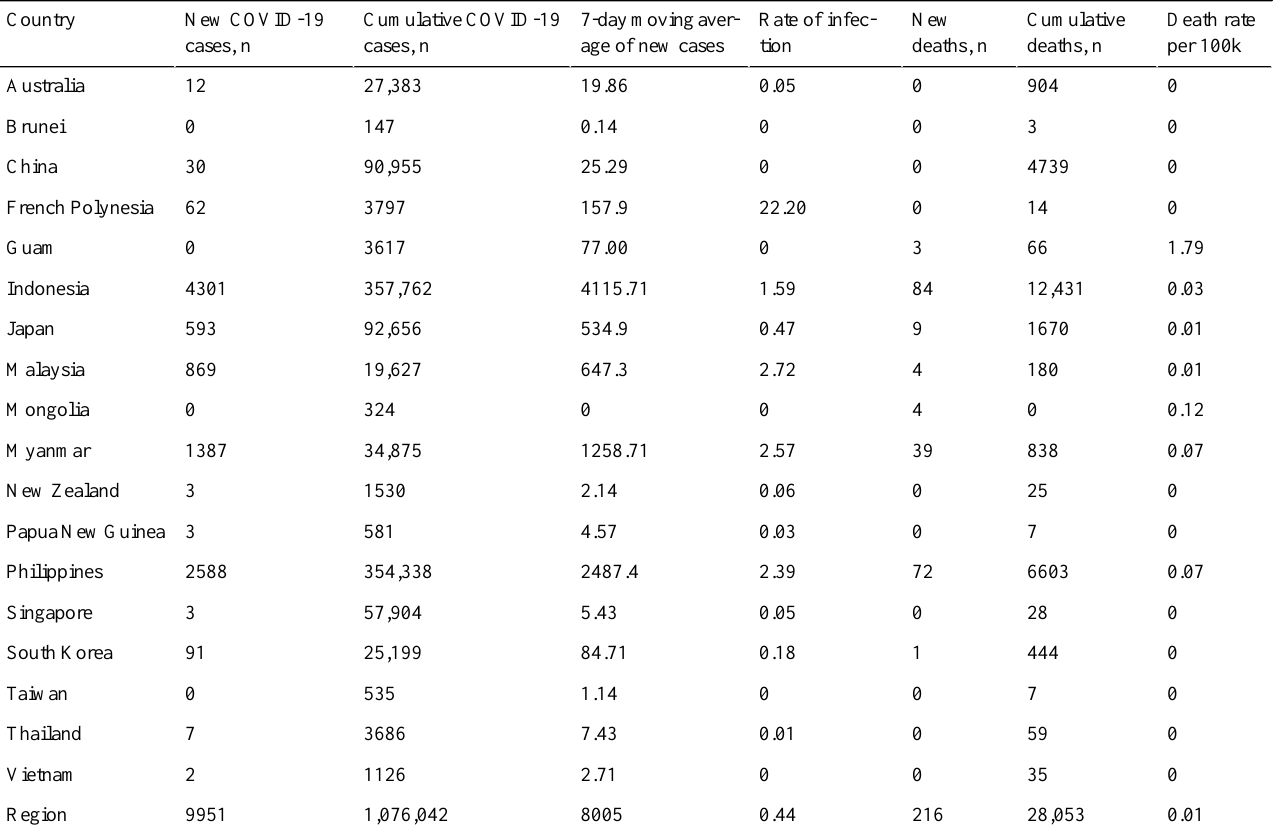
Table 3. Static surveillance metrics for the week of October 12-18, 2020.